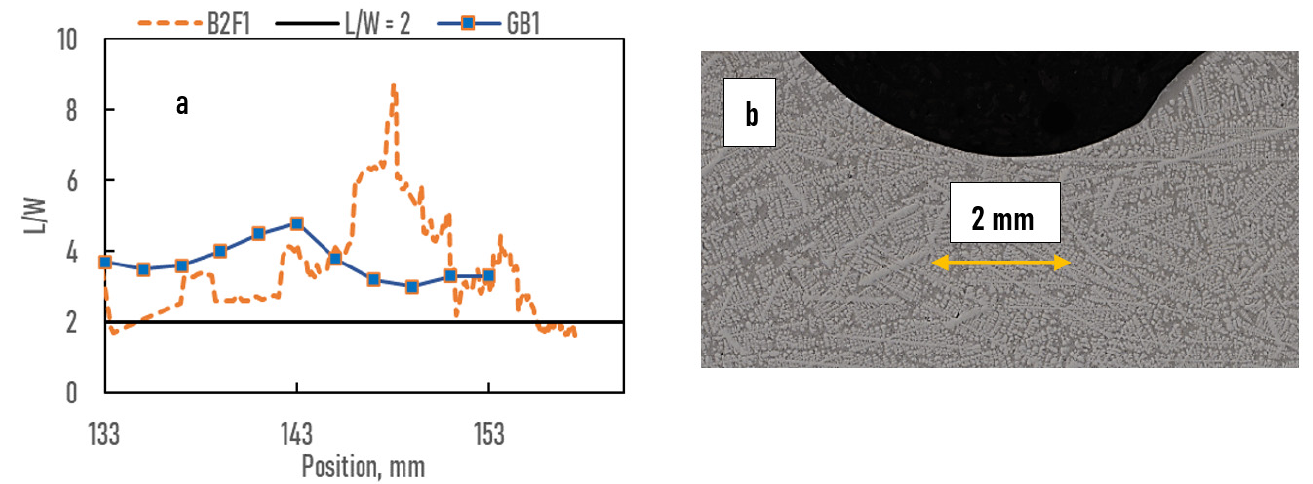
Figure 16. ( a ) L/W versus position of B2F1 and GB1 samples; ( b ) microstructure of B2F1 sample at 148 mm with a surface pore.